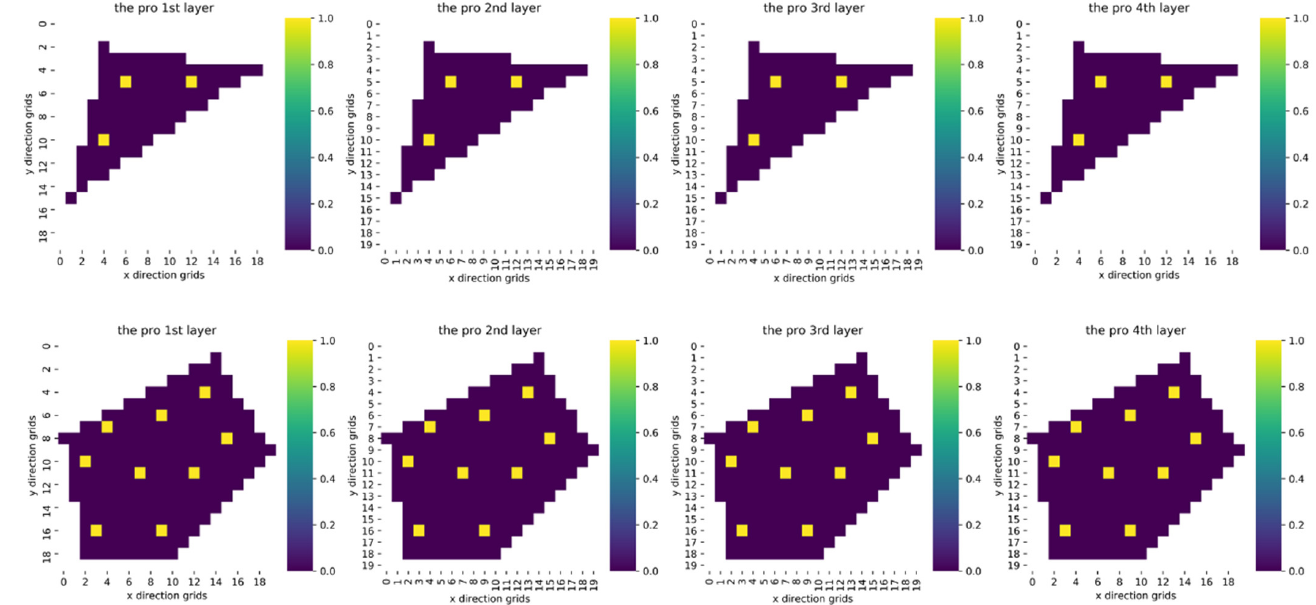
Figure 13. Irregular boundary shape and well placement in both cases (the yellow points denote a well position).